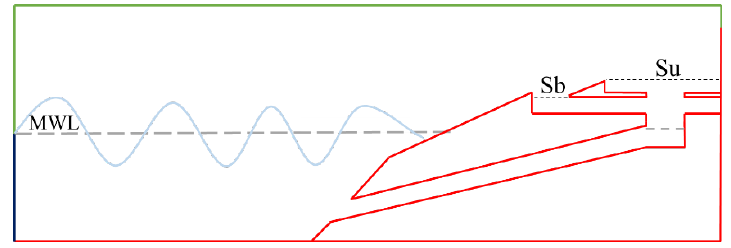
Figure 8 indicates the gauges Sb and Su to measure the mass flow rate of water, respectively, from the bottom ramp and the upper ramp. Therefore, with the instantaneous . m measured, the averages were calculated for the 100 s of simulation and the values of values used in Equation (5) to determine the average overtopping flow Q (Equation (1)). Figure 7. Illustration of the position of gauges S1, S2, S3 S4 and Sor.